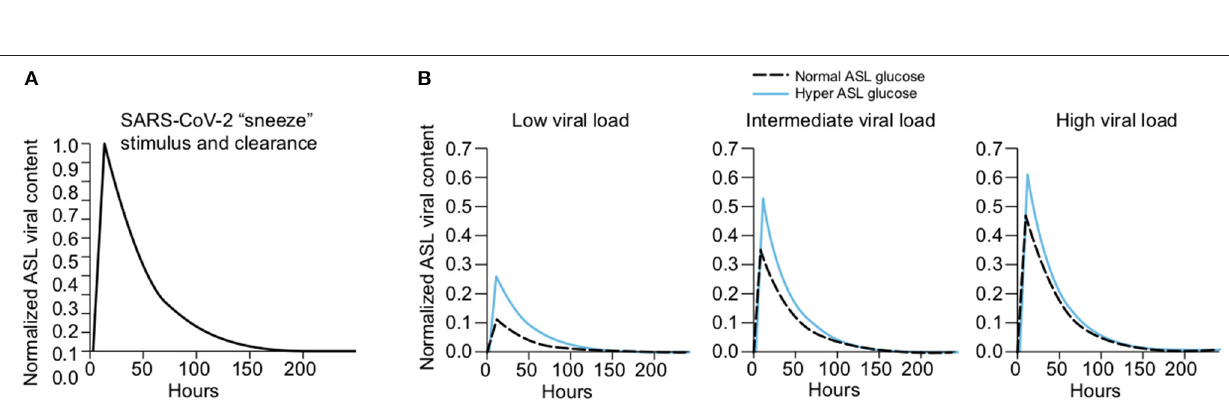
FIGURE 21 | Computational modeling of glucose-dependent SARS-CoV-2 infection. (A) Schematic representation of the parameters used in the different SARS-CoV-2 primary infection computational models. Blood glucose concentration and epithelial resistance (Rt) determine the glucose concentration in ASL. In the ASL, the number of virions, the concentrations of lectins and glucose determine the number of virions that reach and attach the receptor ACE2 for further endocytosis. Glucose in excess bind to lectin, leaving the virus free to reach the receptor. Epithelial glucose is depending on the ASL glucose concentration and the GLUT transporter number and activity. After endocytosis, the virus hijacks the metabolism of the cell and uses this epithelial glucose to replicate (epithelial virus number increases), leading to the production of lactate, which is released in the ASL, further lowering the pH of the ASL. GLUT, Glucose transporters ( 1, 2, 10); Rt, paracellular resistivity (1/Rt = paracellular conductivity in model) (see section Methods for details). (B) Simplified modeling of SARS-CoV-2—ACE2 binding, as a function of the viral load (represented by three different viral contents at the time of infection, see Definition of viral loads in methods) in a normoglycemic (0.4mM ASL glucose) or hyperglycemic patient (1.2mM ASL glucose).